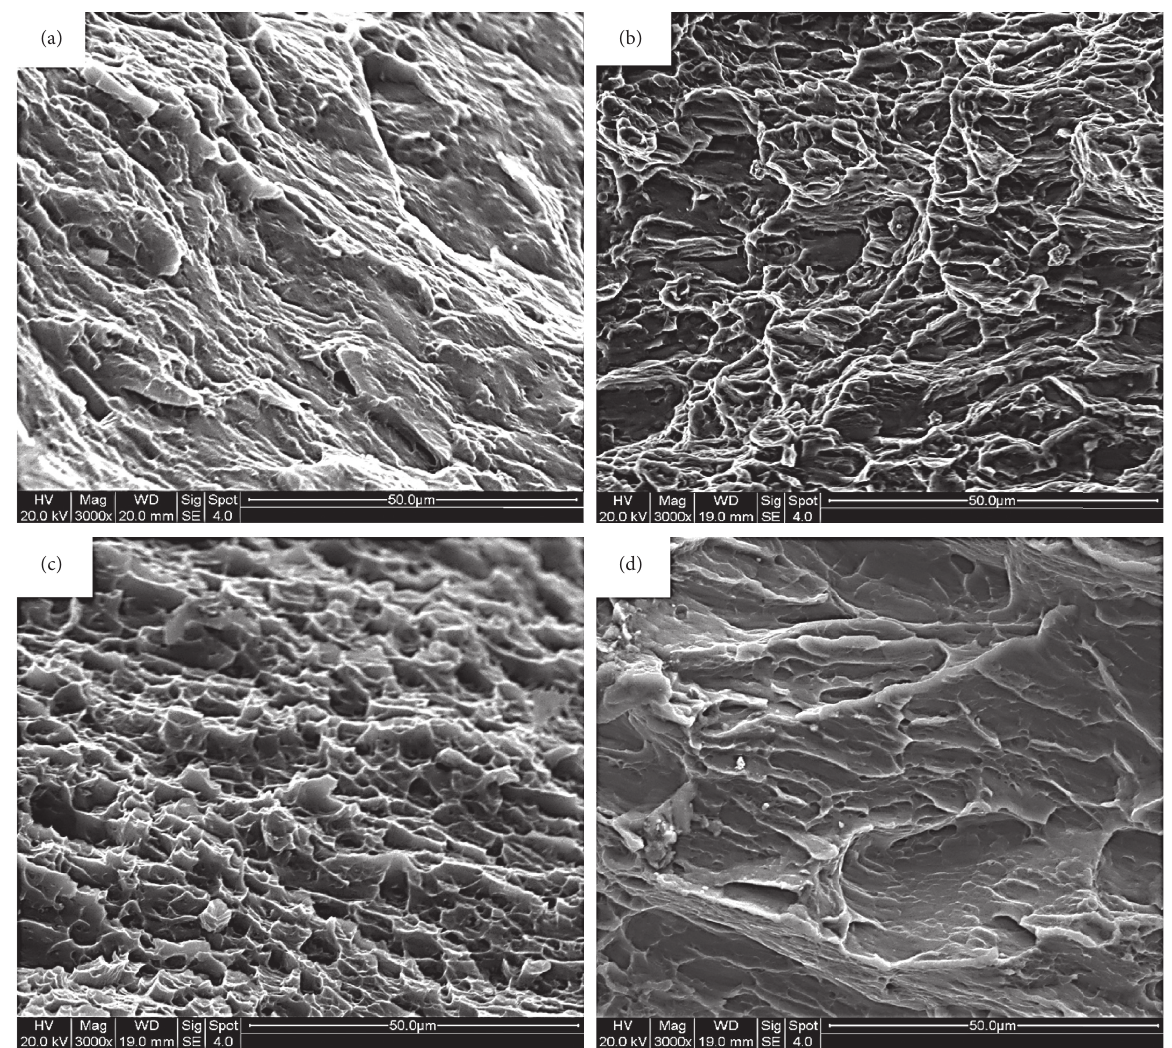
Figure 19: Fracture feature along the skins with different traverse speeds: (a) 15mm/min; (b) 30mm/min; (c) 50mm/min; (d)